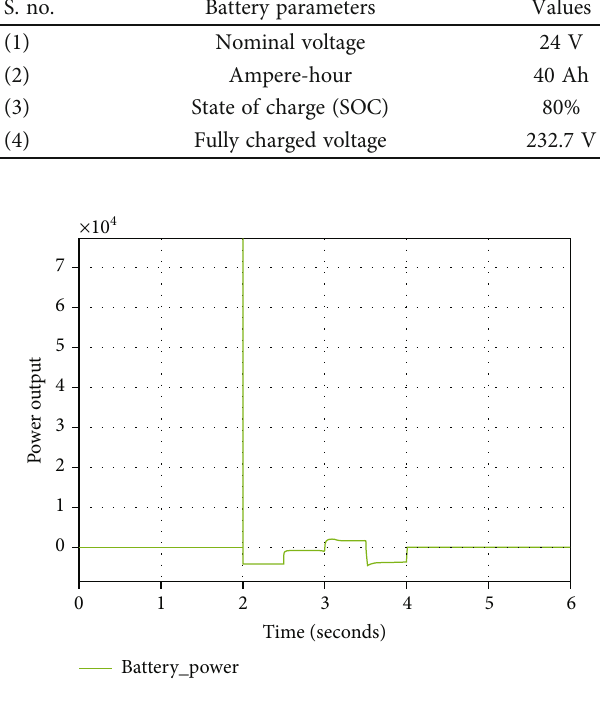
Figure 3: Battery